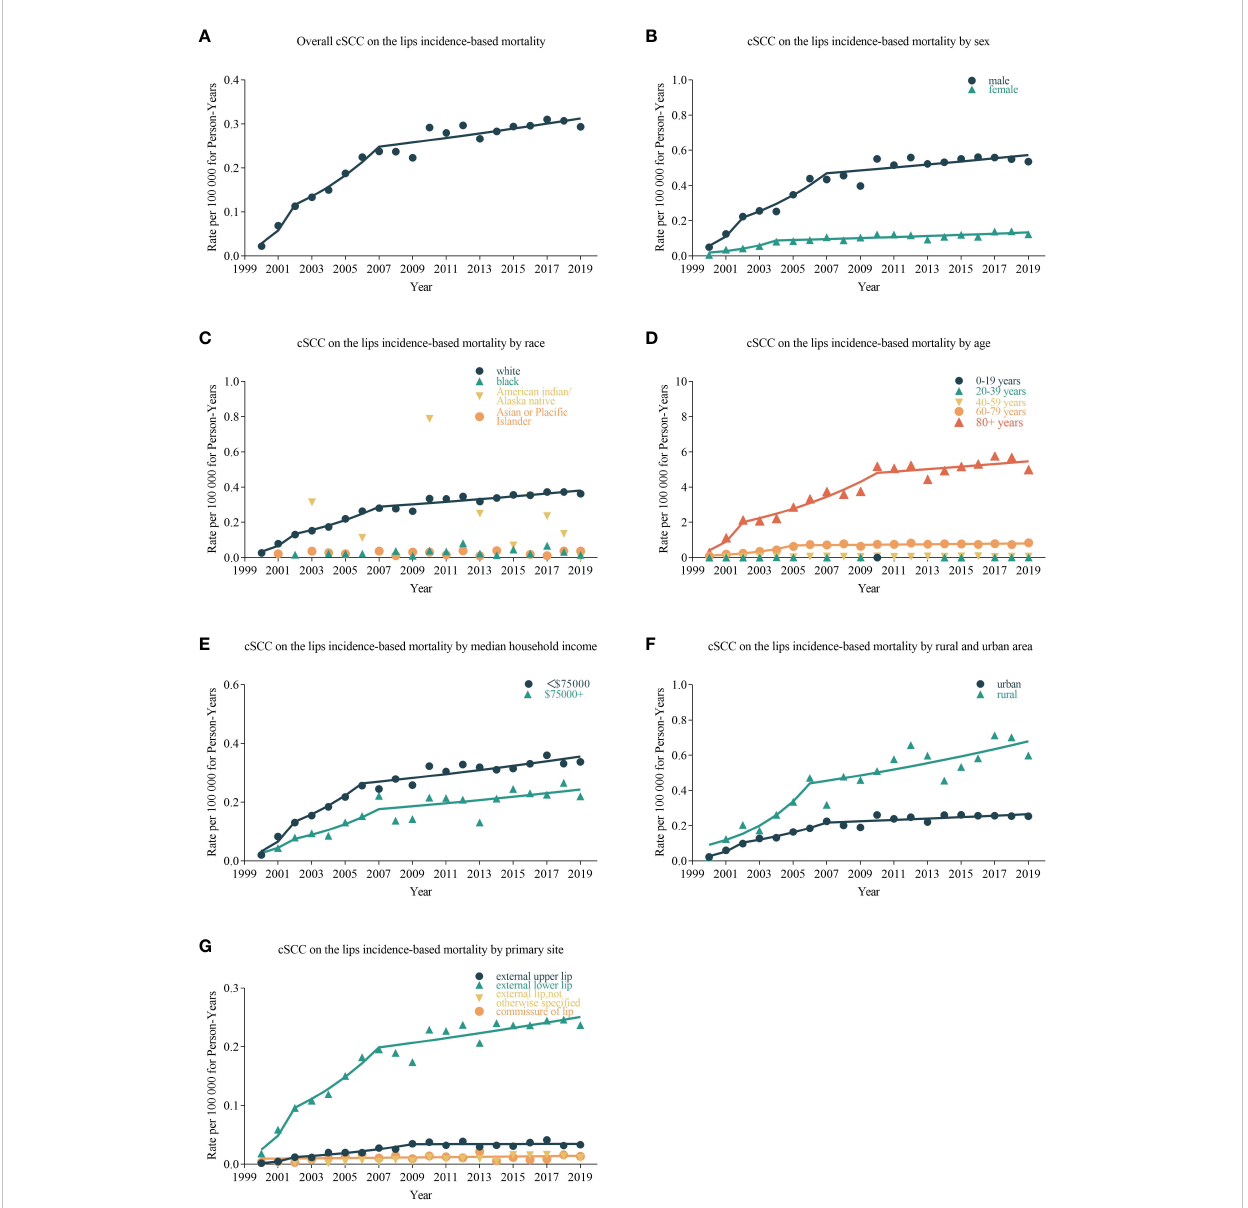
FIGURE 2 Trends in annual cSCC on the lip incidence-based mortality rates. Data markers represent observed incidence-based mortality rates (per 100,000 person-years). The slope of the line shows the annual percentage change (APC). (A) The overall incidence-based mortality and trend of cSCC on the lips patients; line graphs are divided into different groups, including sex (B) , race (C) , age (D) , median household income (E) , urban and rural area (F) , and primary site (G)